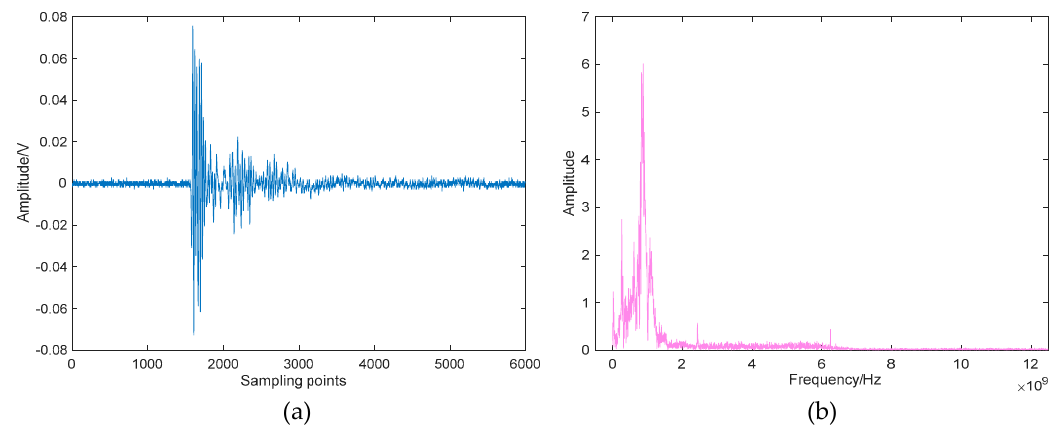
Figure 17. UHF PD signal measured in field test: ( a ) Time-domain waveform; ( b ) Spectrum.